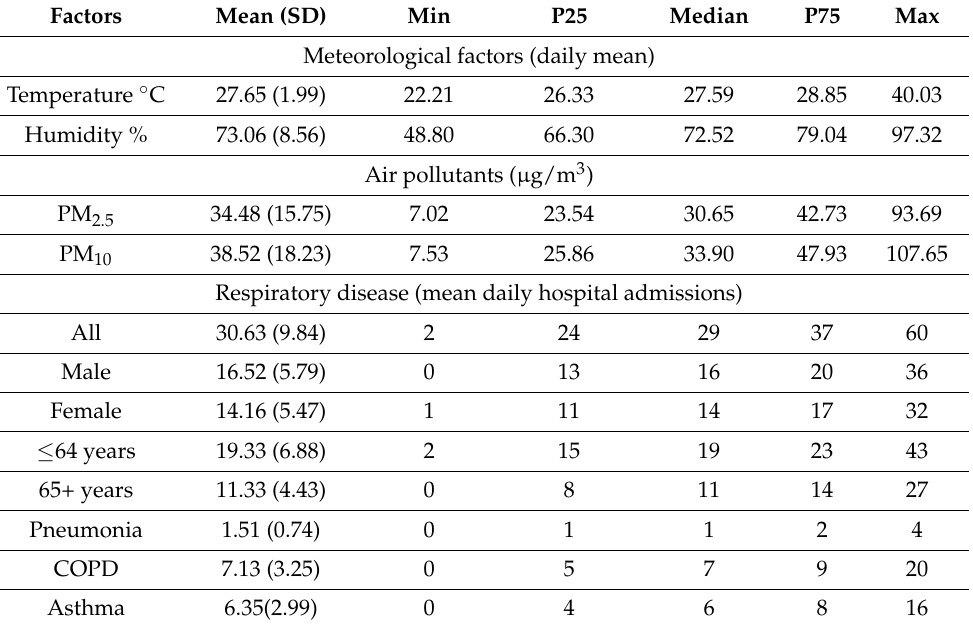
Table 1. Descriptive statistics for daily respiratory disease hospitalization, daily meteorological factors and air pollutants in Kandy,